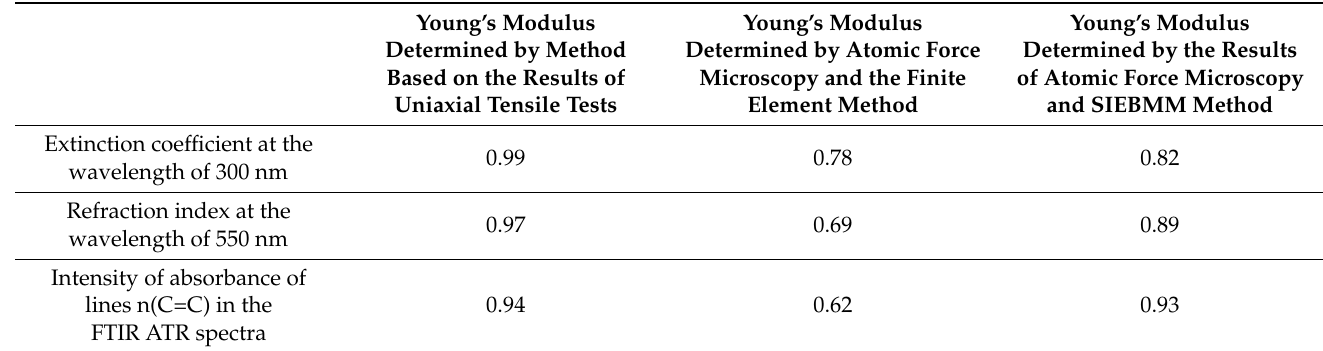
Table 1. Values of the Pearson correlation coefficient obtained by comparing the values of elastic modulus obtained by three methods with the values of characteristics indicating carbonization of the surface